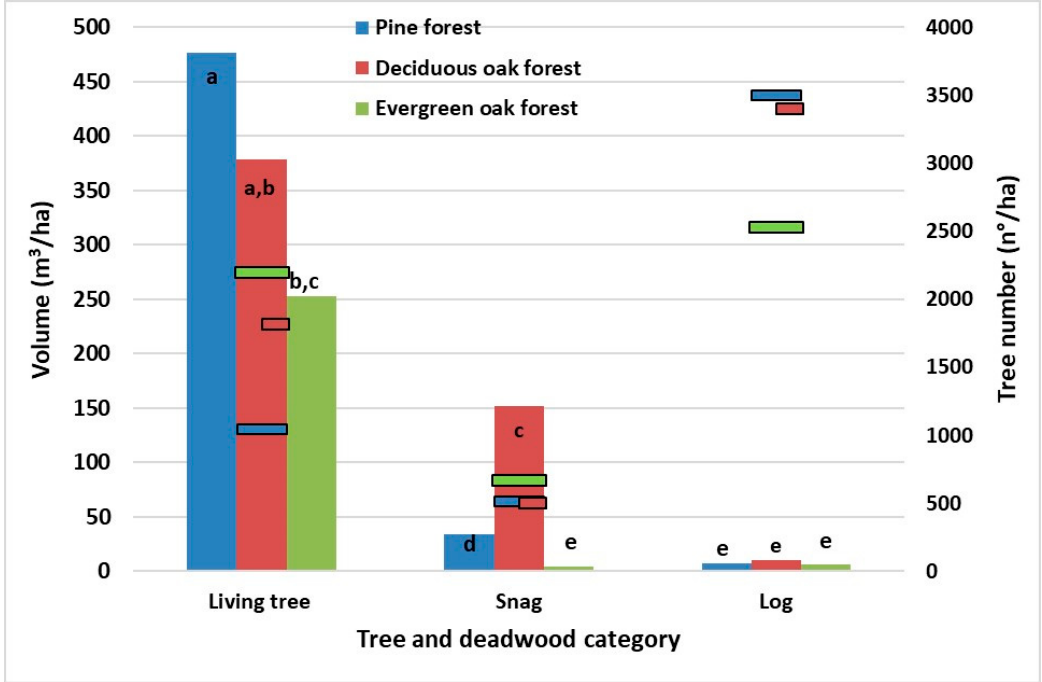
Figure 3. The histograms show the growing stock (left y-axis) and the scatter bars show the tree number (right y-axis) of living trees and deadwood. For the variable volume, ANOVA test showed differences statistically significant, HSD post hoc test was applied and the results showed five homogeneous groups, shown in the graph by different letters.